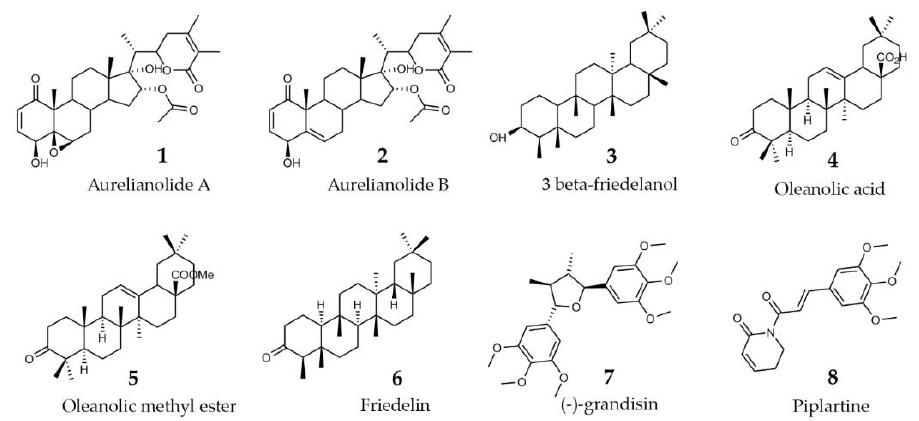
Figure 2. Chemical structures of the studies purified substances.